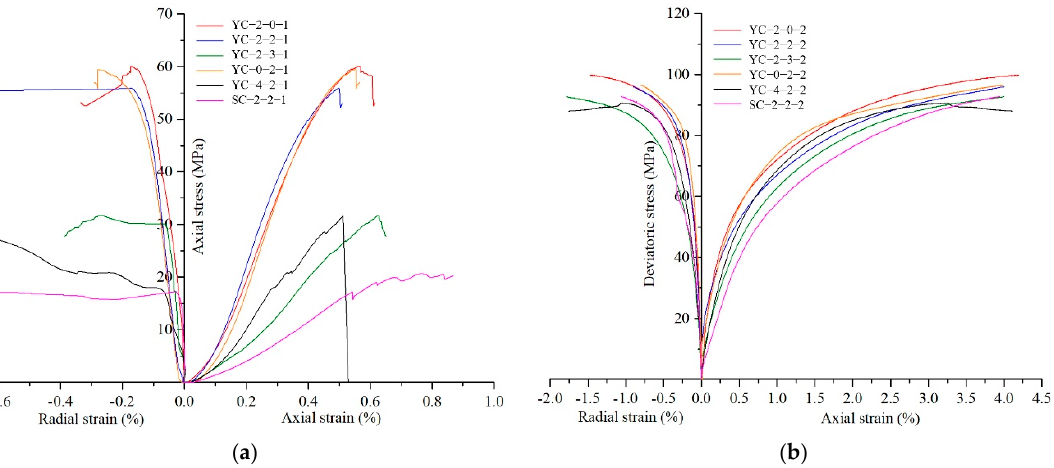
Figure 7. Stress–strain curves of composite rock–cement specimens under uniaxial and triaxial compression. ( a ) Stress–strain curves under uniaxial compression, ( b ) Stress–strain curves under triaxial compression.